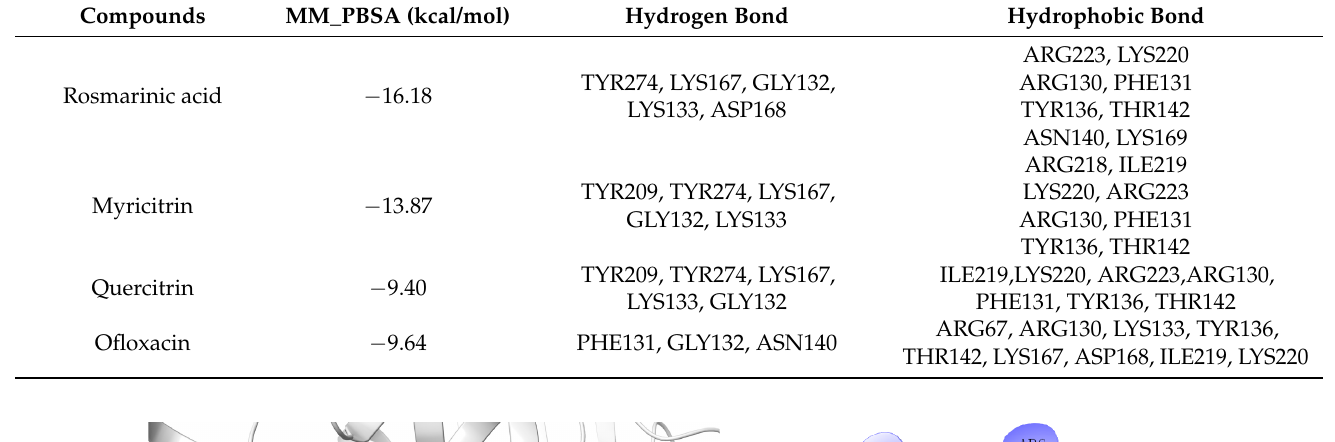
Table 2. The MM_PBSA and hydrogen/hydrophobic bonds between the selected compounds and TOP1.